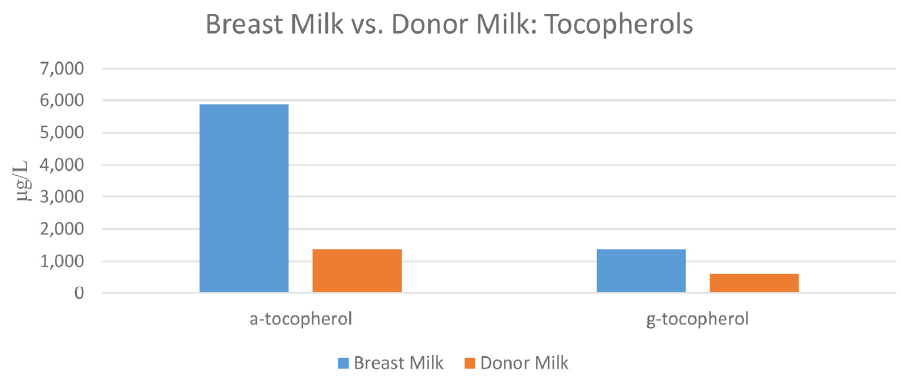
Figure 2. The concentrations of α‐ tocopherol and γ‐ tocopherol in maternal breast milk vs. donor milk samples. All values were significantly different ( p = 0.009 and 0.01 for α‐ tocopherol and γ‐ tocopherol, respectively).